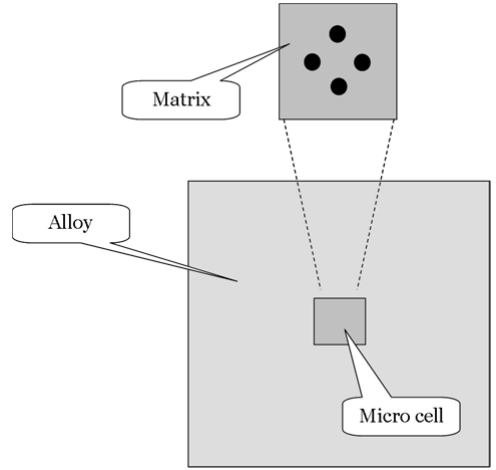
Figure 23. Schematic configuration of a micro-cell